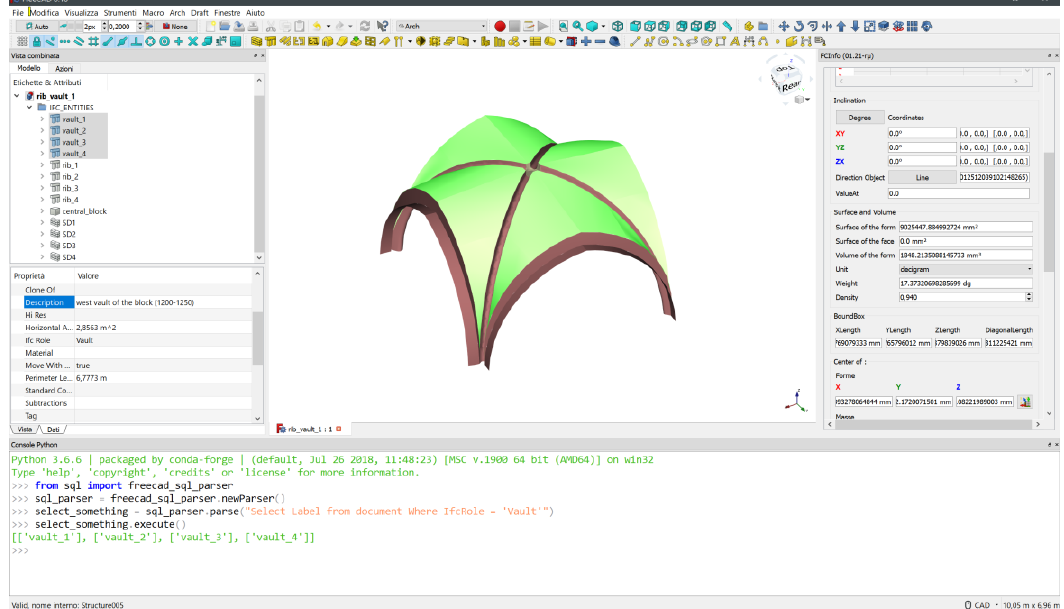
Figure 12. SQL query performed on Python console in order to investigate Vault IFC custom role: results in green text inside square brackets after the SQL query syntax.